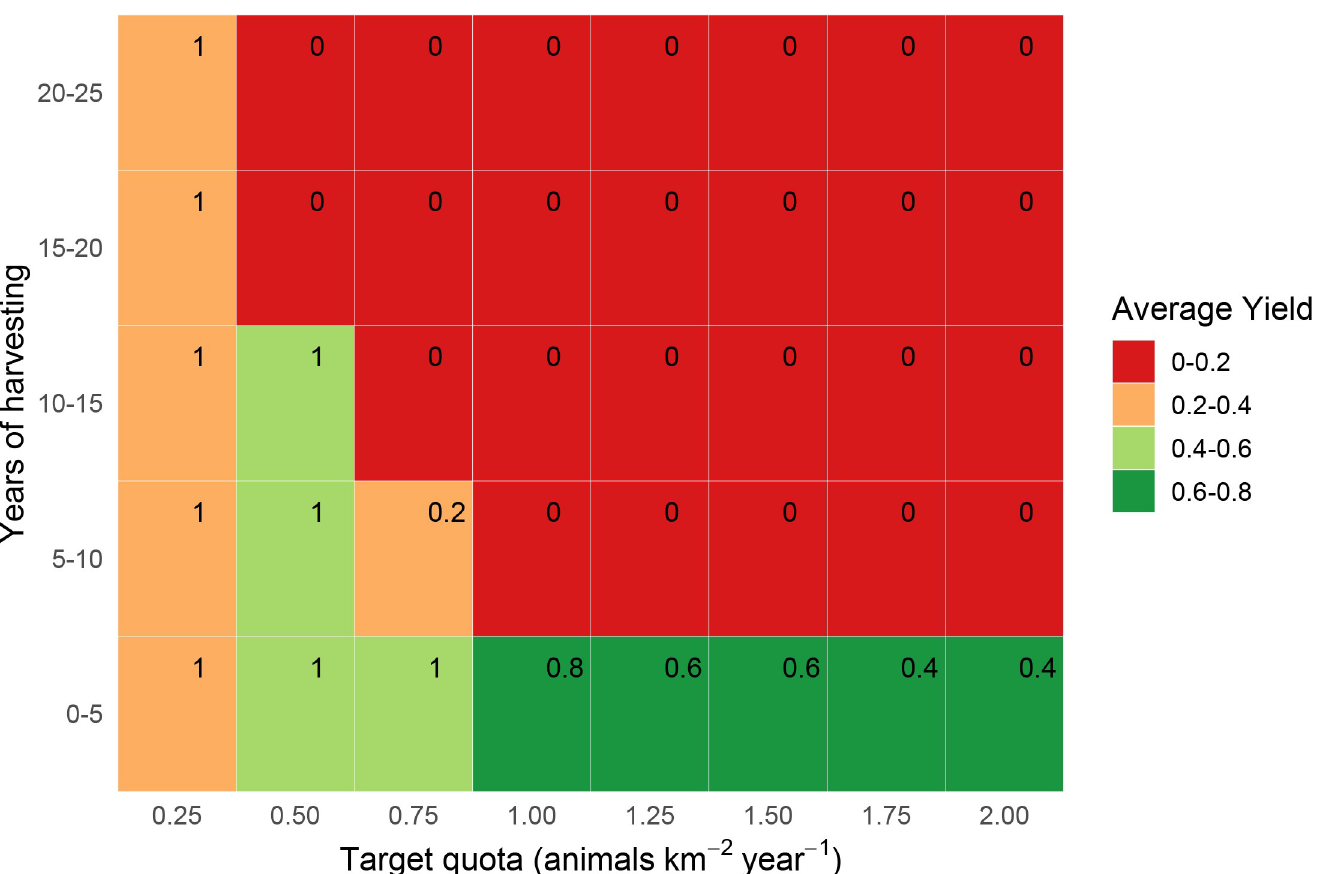
Fig 4. Estimated yields (animals km -2 year -1 ) from quota-based harvesting of bay duiker C . dorsalis . Yields are estimated over 25 years in 5-year increments, without parameter uncertainty, with corresponding survival probabilities (in top-right corner of each rectangle).